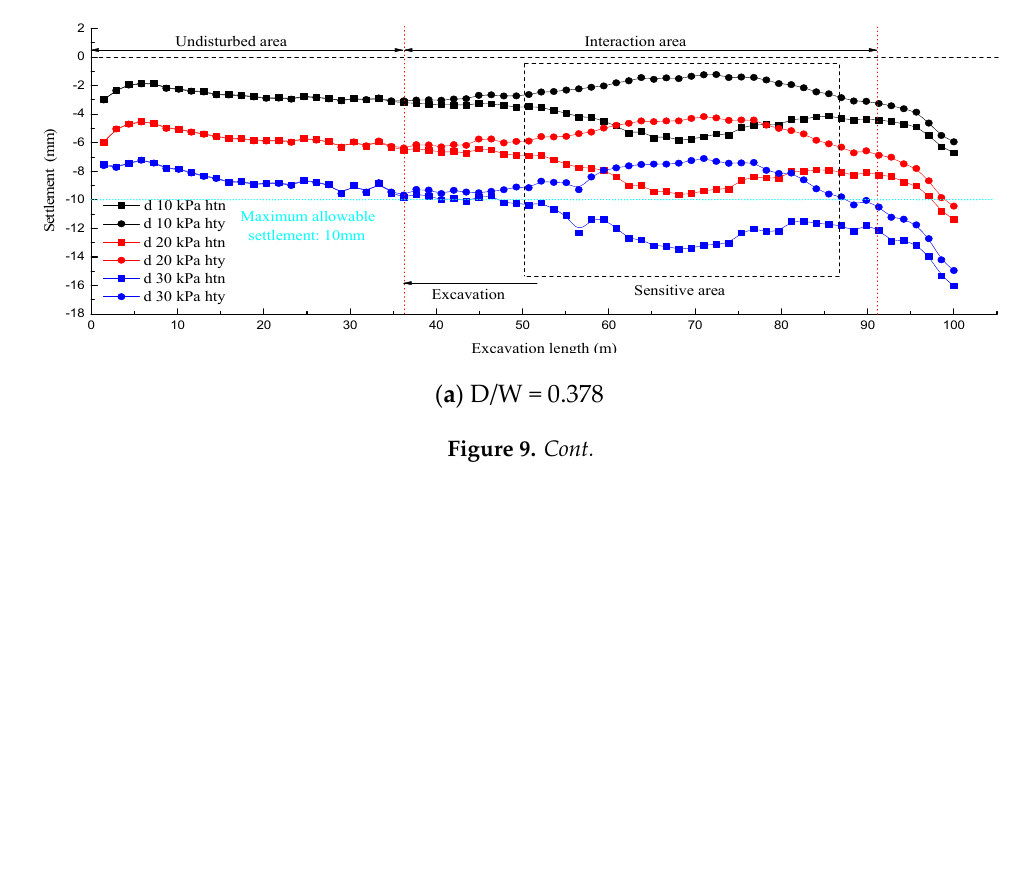
Figure 8. Longitudinal surface settlement of models A-A to C-C.